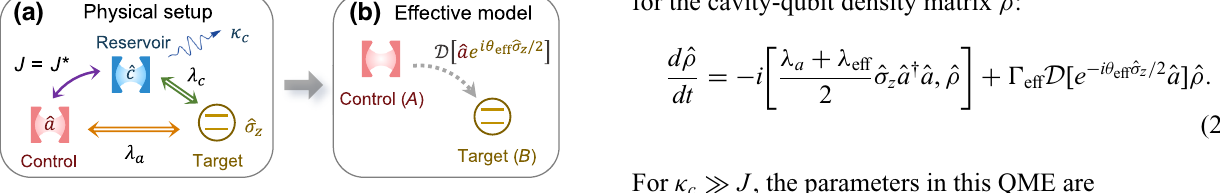
FIG. 2. (a) Schematic of a setup that realizes a nonreciprocal interaction from a cavity mode a ( A ) to a qubit ( B ). Both sub- systems are coupled to an auxiliary damped bosonic mode c that plays the role of a reservoir; see Eq. (28). (b) The effective dissi- pator describing the nonreciprocal interaction in the Markovian reservoir limit κ c (cid:20) J